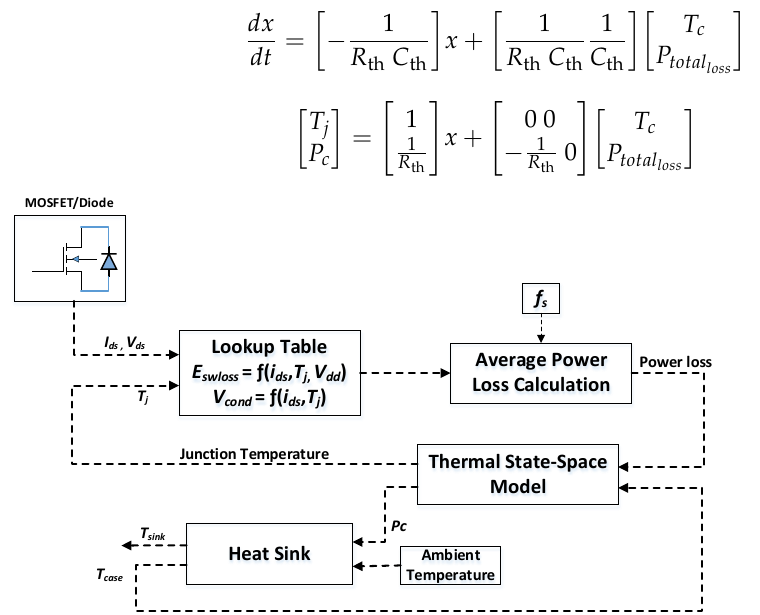
Figure 16. Power losses and thermal model block diagram.